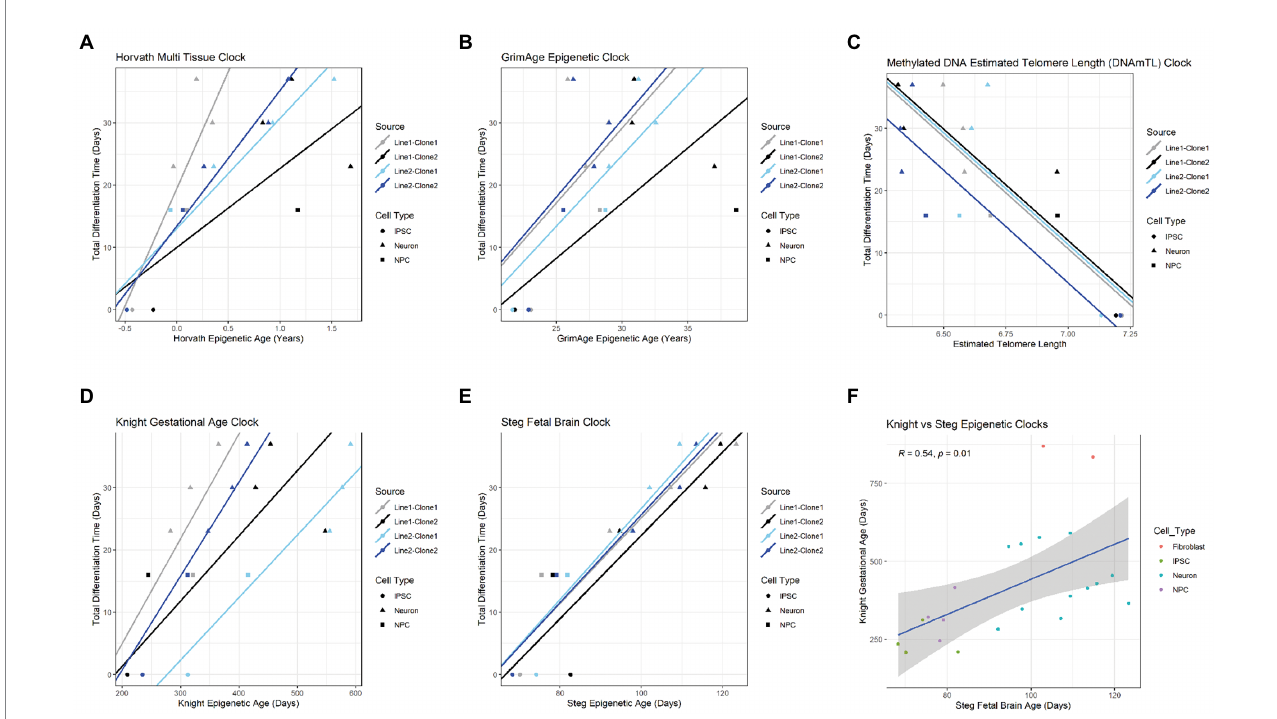
FIGURE 3 Comparison of multiple epigenetic clocks via Bayesian linear mixed model. Plots comparing Horvath Adult Epigenetic Clock (A) , GrimAge Clock (B) , DNAmTL Clock (C) , Knight Gestational Age Clock (D) and Steg Fetal Brain Clock (E) . For each plot, age score is plotted against approximate total differentiation time (from iPSC stage) and linear effects model for each cell clone is demarcated by the plot line. Colors indicate clone, shapes indicate cell type. (F) Correlation plot between Knight Gestational Age Clock and Fetal Brain Clock, Pearson correlation coefficient and value of p labeled at top. Cell type noted by color. Linear regression line labeled surrounded by gray standard error field.